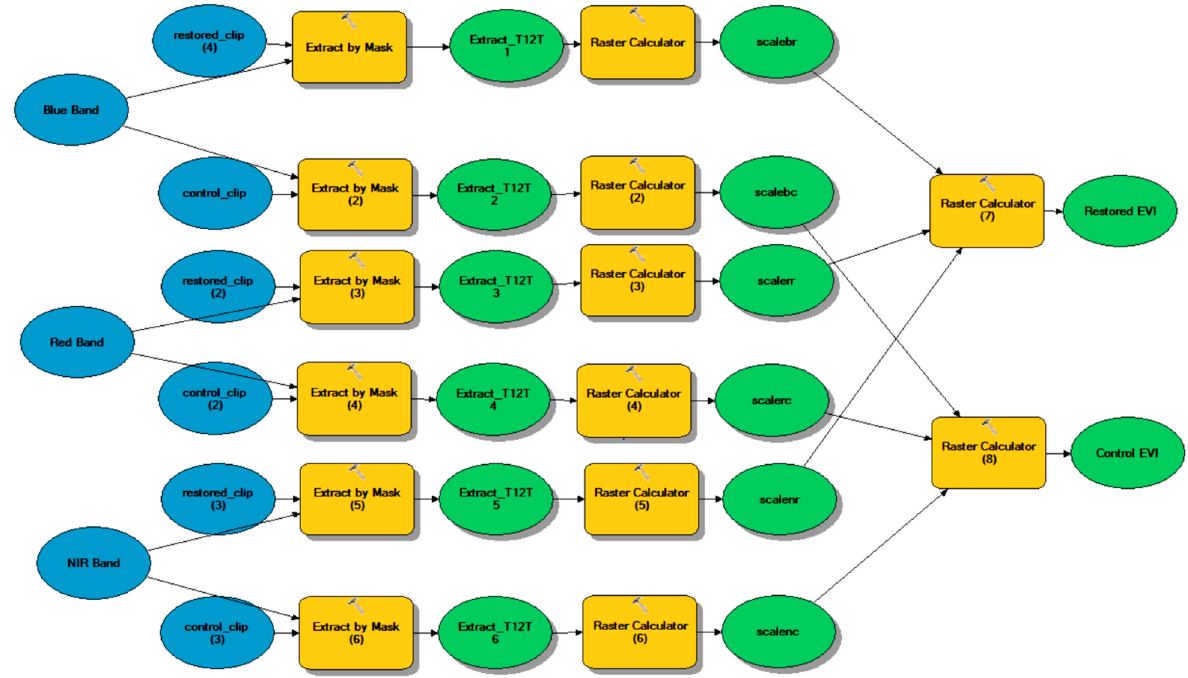
Figure A1. ArcMap flow diagram for EVI values computation (for satellite data only). Blue ovals refer to corresponding reflectance band raster files, treatment, and control clips. The yellow rectangles refer to ArcMap tools. The green ovals refer to output of the products.